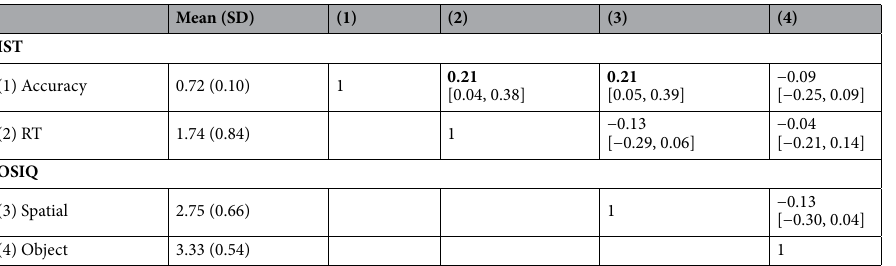
Table 1. Mean (SD), and matrix of correlations [l-95% CI, u-95% CI]. (1) IST, Accuracy = Accuracy in the image-scanning task. (2) IST, RT = response time in the image-scanning task. (3) OSIQ, Spatial = mean score of the spatial imagery scale. (4) OSIQ, Object = mean score of the object imagery scale. Estimates with credible intervals that do not include zero are in